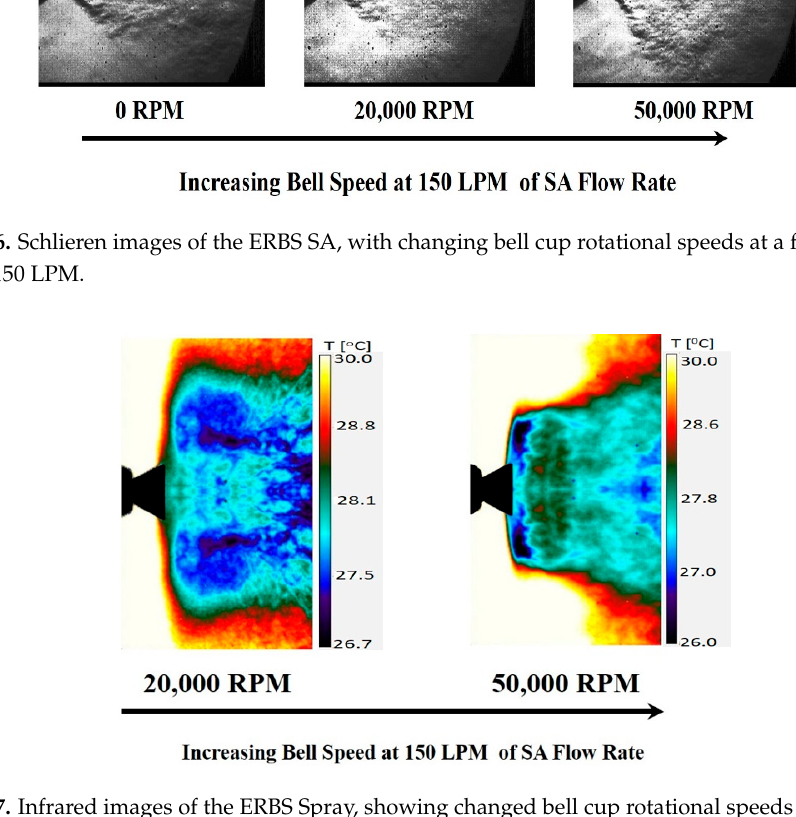
Figure 7. Infrared images of the ERBS Spray, showing changed bell cup rotational speeds at a fixed SA flow rate of 150 LPM and a fixed liquid flow rate of 0.1 LPM.